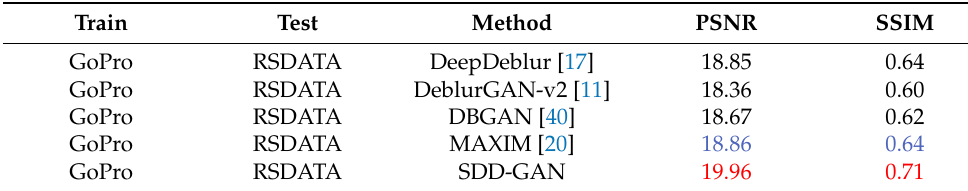
Table 1. Average PSNR and SSIM for different deblurring methods on the RSDATA dataset (trained on the GoPro dataset). The highest scores are highlighted in red, and the second highest scores are highlighted in blue.